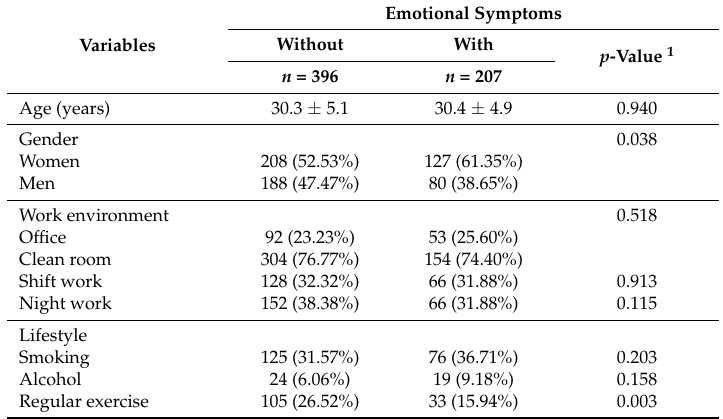
Table 1. Basic characteristics of study population and distribution of emotional symptoms.